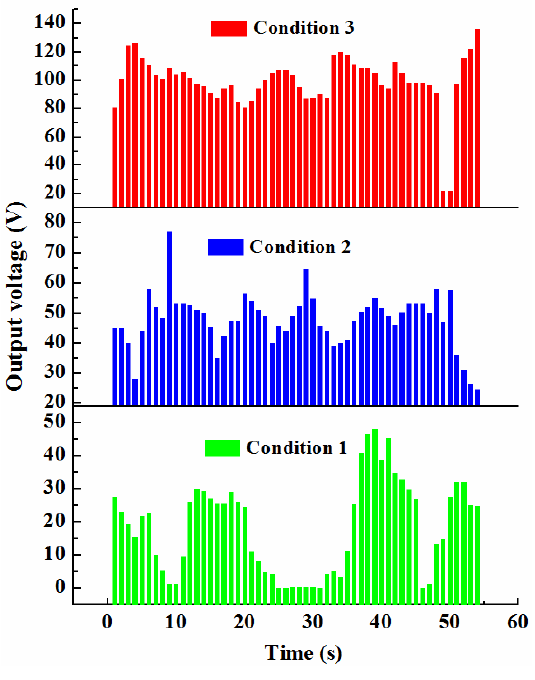
Figure 11. Output voltage under natural